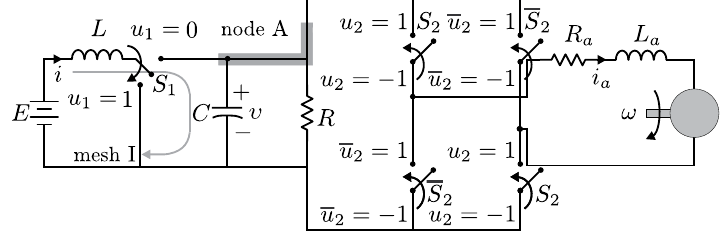
Figure 2. Ideal circuit of DC/DC boost converter–inverter–DC motor system.